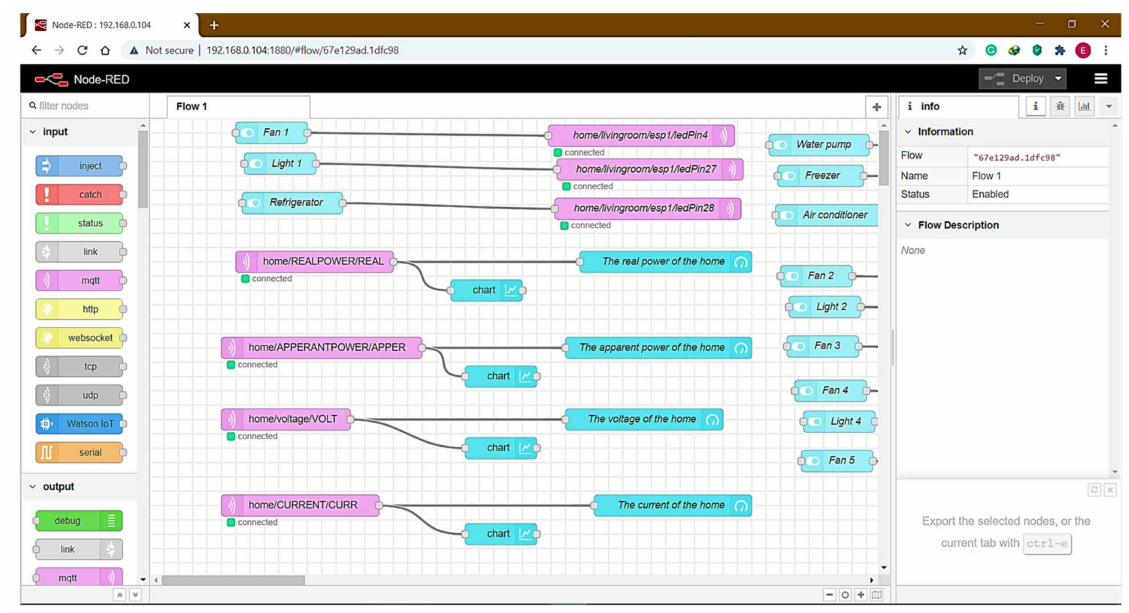
Figure 8. Node-Red